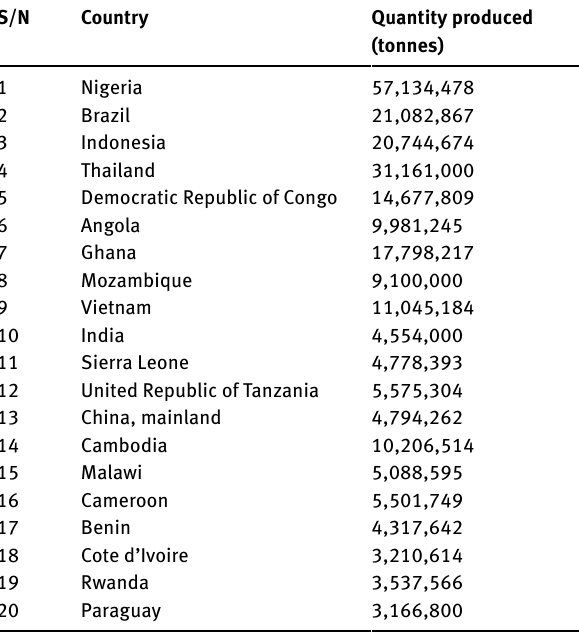
Table 1: List of 20 countries that are Top Producers of Cassava in the World